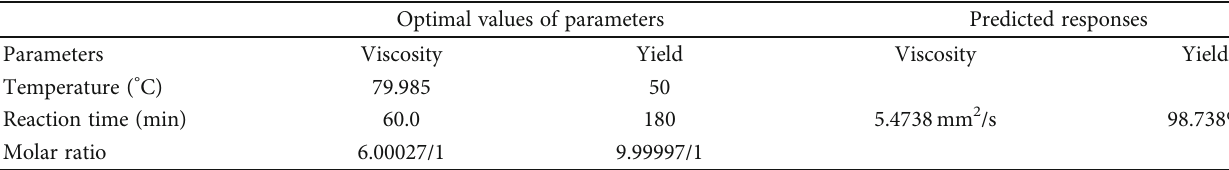
Figure 5: (a) Response surface contour for the e ff ect of the interaction between time and molar ratio on yield (KOH concentration: 1wt.%). (b) Response surface contour for the e ff ect of the interaction between time and temperature on yield (KOH concentration: 1 wt.%). Table 5: Optimal viscosity and yield